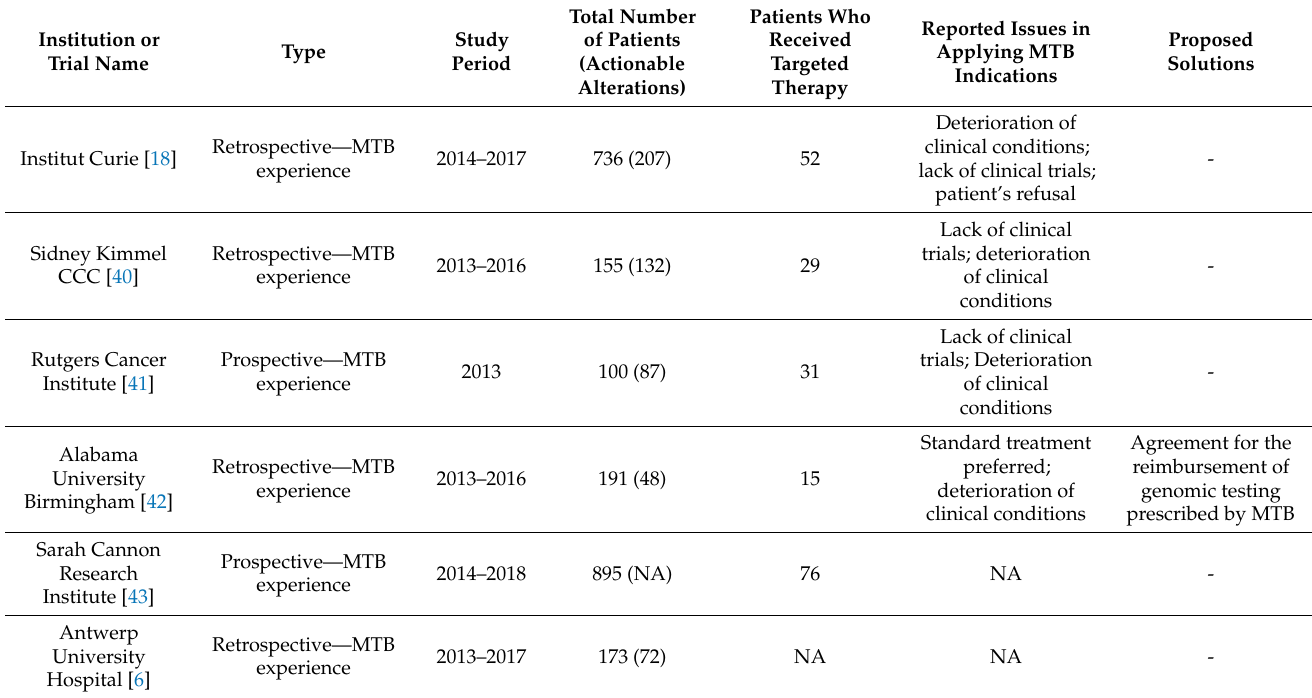
Table 1. Overview of the literature illustrating the most frequent reasons preventing access to the targeted therapies indicated by MTBs. NA: Not Available; TT: targeted